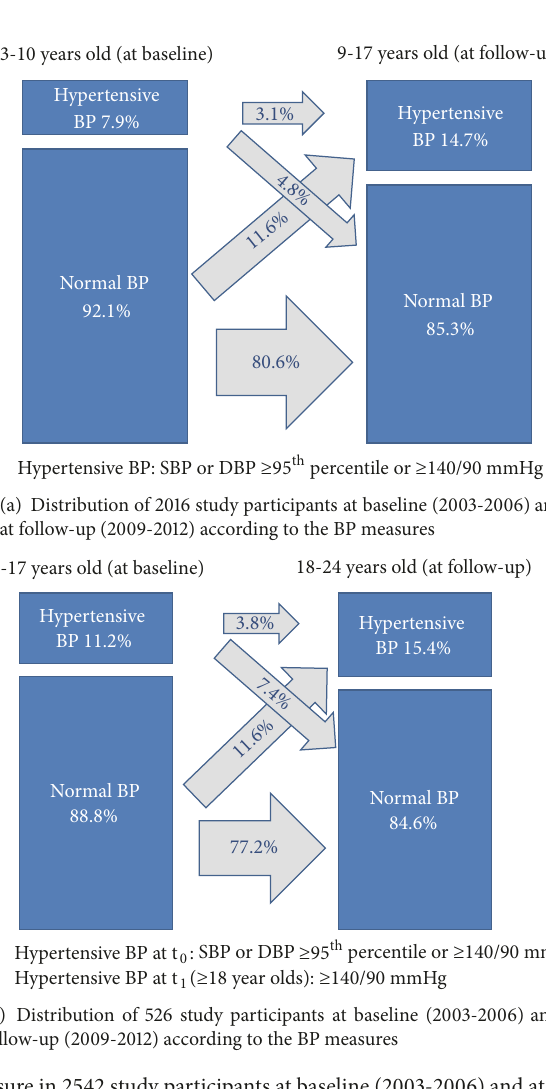
follow-up were observed in obese children at baseline (50%; 95%CI 27-74) and children with a hypertensive BP at baseline and parental hypertension (48%; 95% CI 30-67) (Table